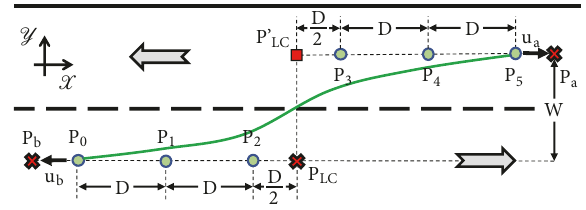
Figure 2: Trajectory planning on lane change.